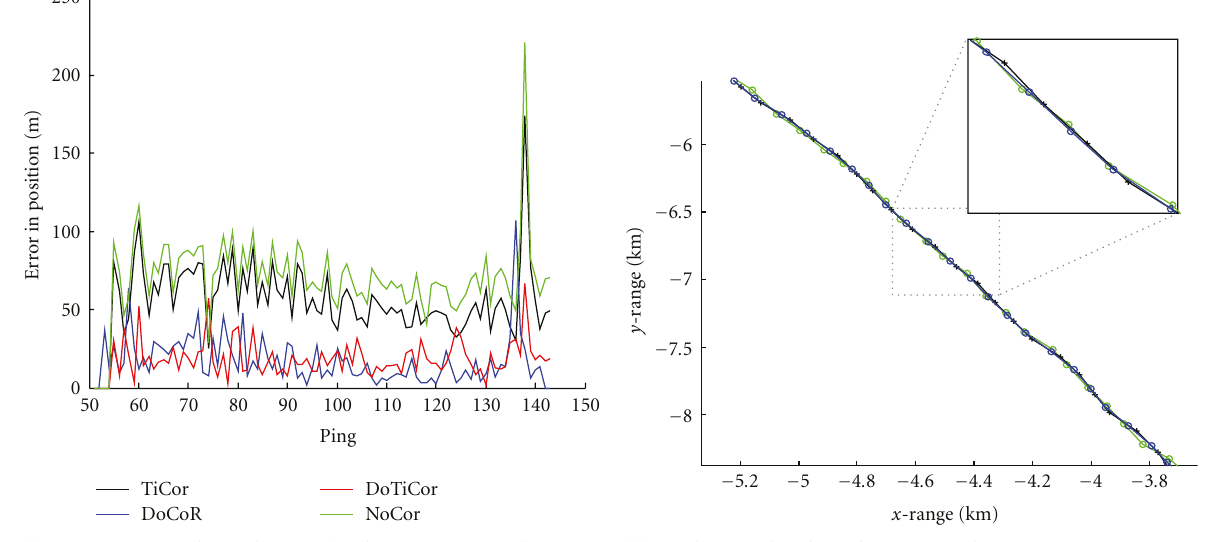
Figure 10: Illustration of improvements in estimation performance when accounting for deterministic features. Results correspond to “AND” fusion of FM contacts of RX1, RX2, and RX3. The latency of the target tracks is about 50 pings.